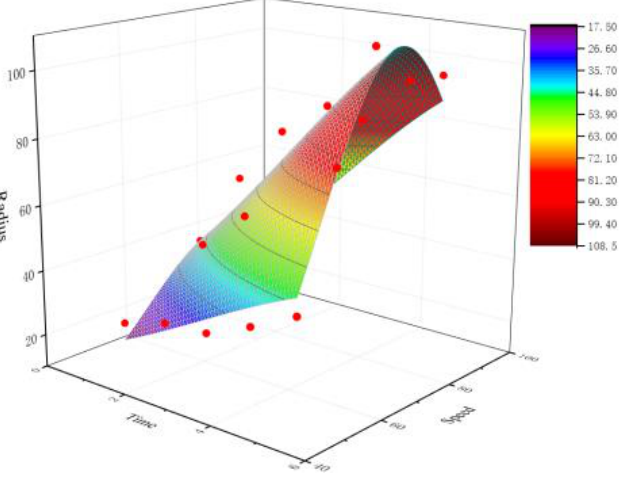
Figure 22. Fitting surface diagram of model 2.